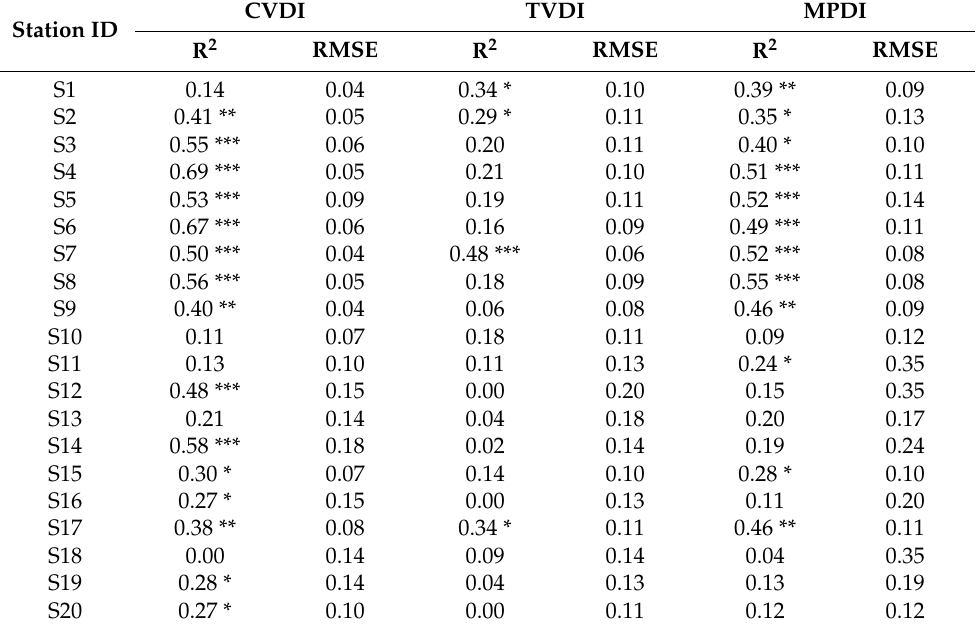
Table 5. Evaluation results between drought indices and AWRA-L SM data for all of the 20 stations. CVDI Station ID